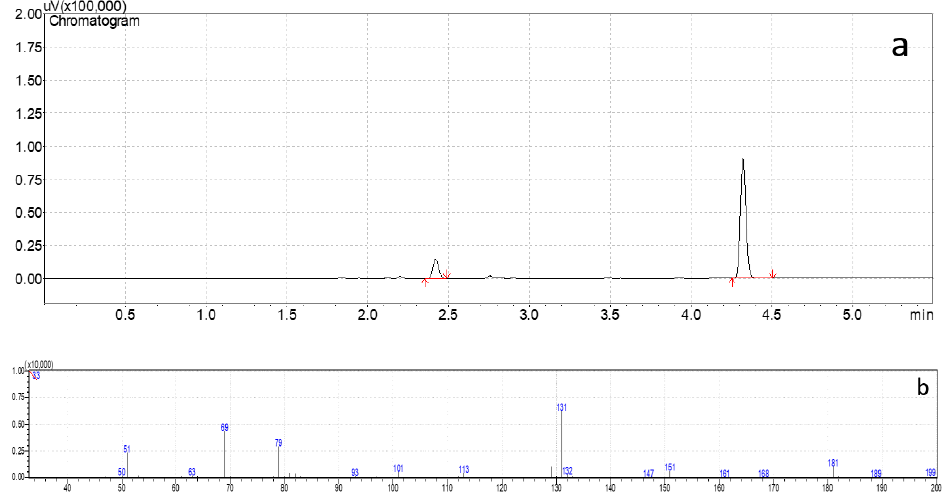
Figure 6. Chromatogram of the real case ( a ) obtained with the validated method in GC–FID ( b ). Mass spectrum of sevoflurane. The ions of m / z 131, 69 and 181 were selected.